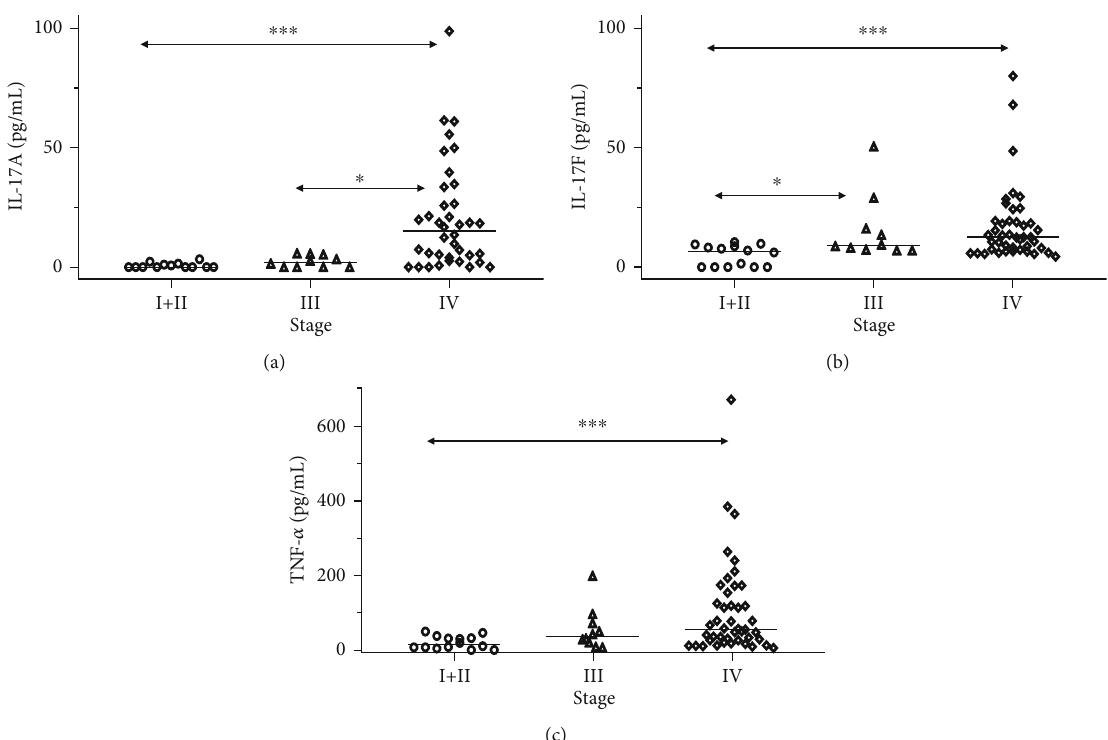
Figure 1: Di ff erences in concentrations of IL-17A, IL-17F, and TNF- α between patients with head and neck cancer at di ff erent stages of disease. (a) There was a signi fi cant di ff erence in salivary concentration of IL-17A ( p < 0 : 001 ) between patients with di ff erent disease stage, and post hoc tests showed signi fi cant di ff erences between stage I/II patients as well as stage III and stage IV patients. (b) There was a signi fi cant di ff erence in salivary concentration of IL-17F ( p < 0 : 01 ) between stages, and post hoc tests showed signi fi cant di ff erences between stage I/II patients as well as stage IV patients and stage III patients. (c) There was a signi fi cant di ff erence in salivary concentration of TNF- α ( p < 0 : 01 ) between stages, and post hoc tests showed signi fi cant di ff erences between stage I/II patients and